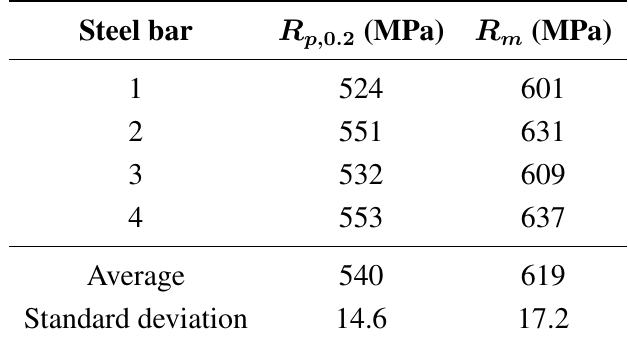
Table 1. The yield, R reinforcement Ø 8.